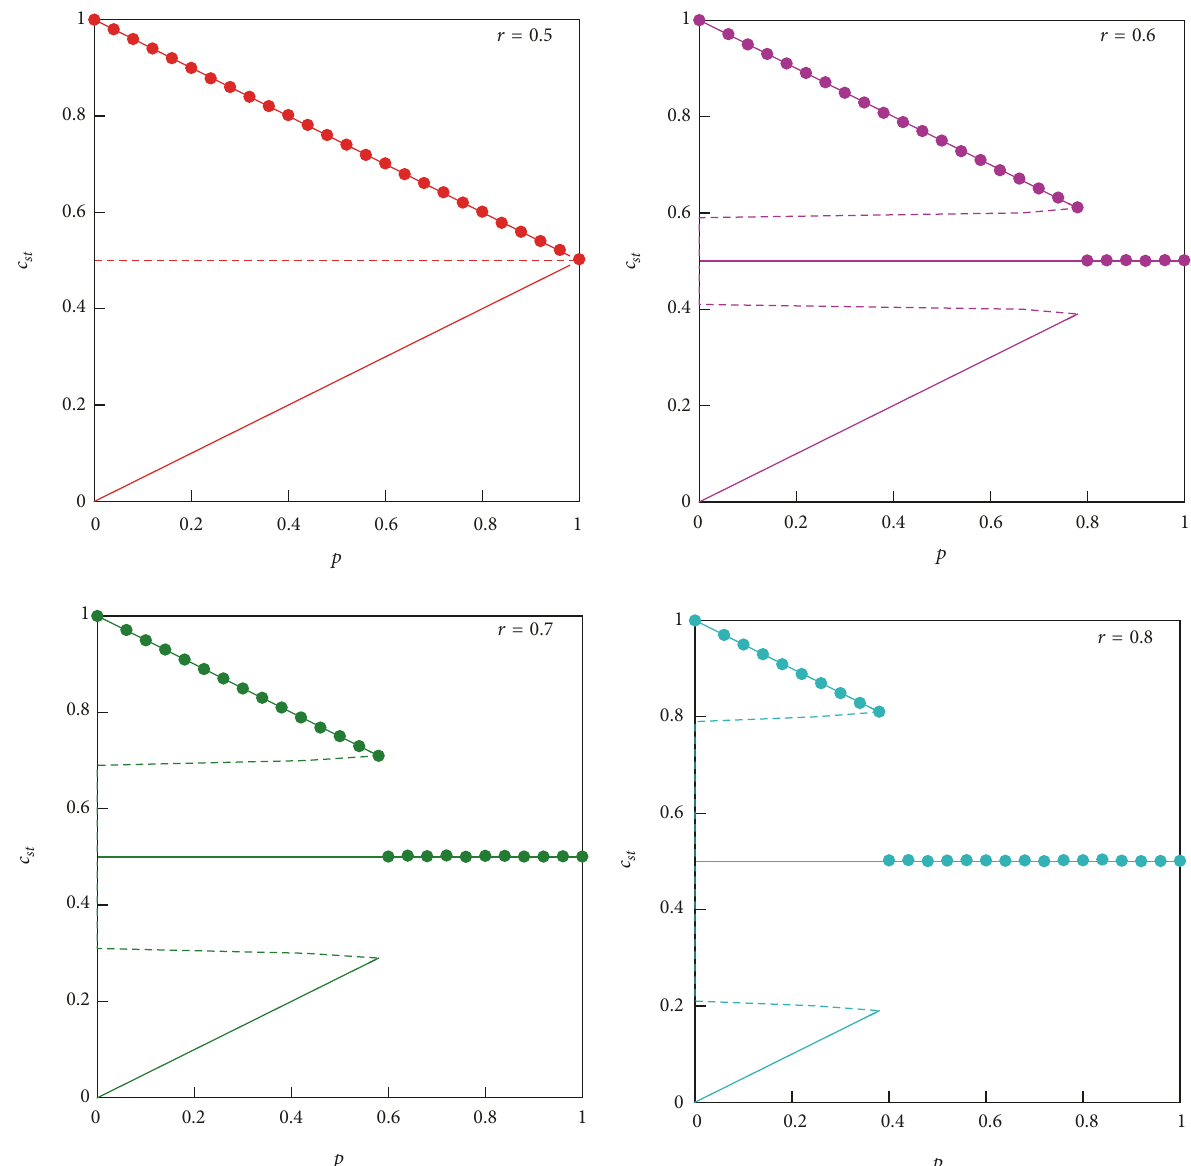
Figure 1: Phase diagrams for the model with independence for different values of the threshold 𝑟 . Lines indicate the analytical prediction from MFA and dots represent results of the Monte Carlo simulations from the initial fully ordered state ( 𝑐(0) = 1 ) for the system of size 𝑁 = 5 ⋅ 10 4